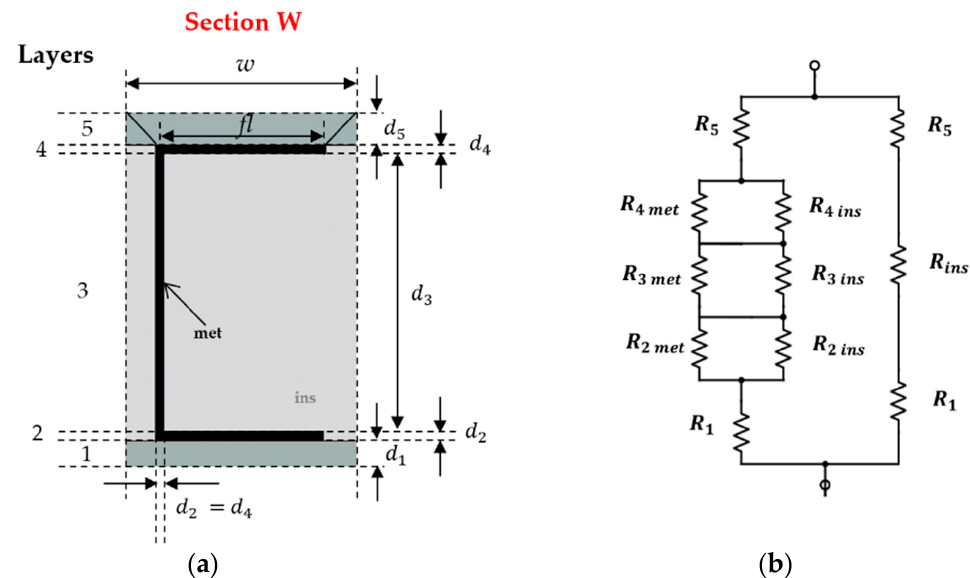
Figure 8. ( a ) Cross section of Section W; ( b ) Equivalent series-parallel circuit.